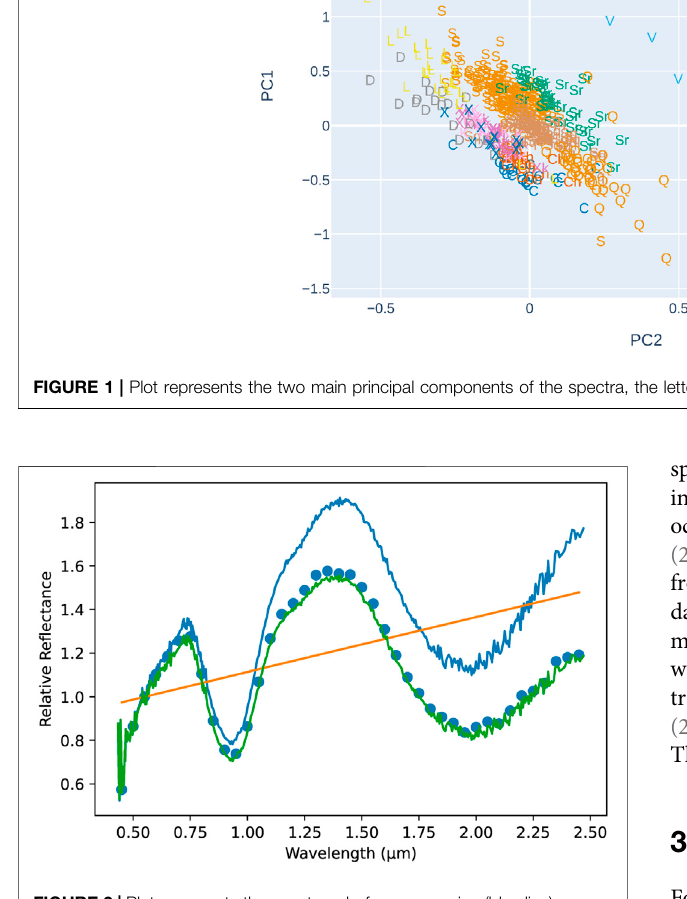
FIGURE 2 | Plot represents the spectrum before processing (blue line), the fi tted slope (orange line), spectrum after processing (green line), and fi nal points (blue dots) for asteroid (1929)